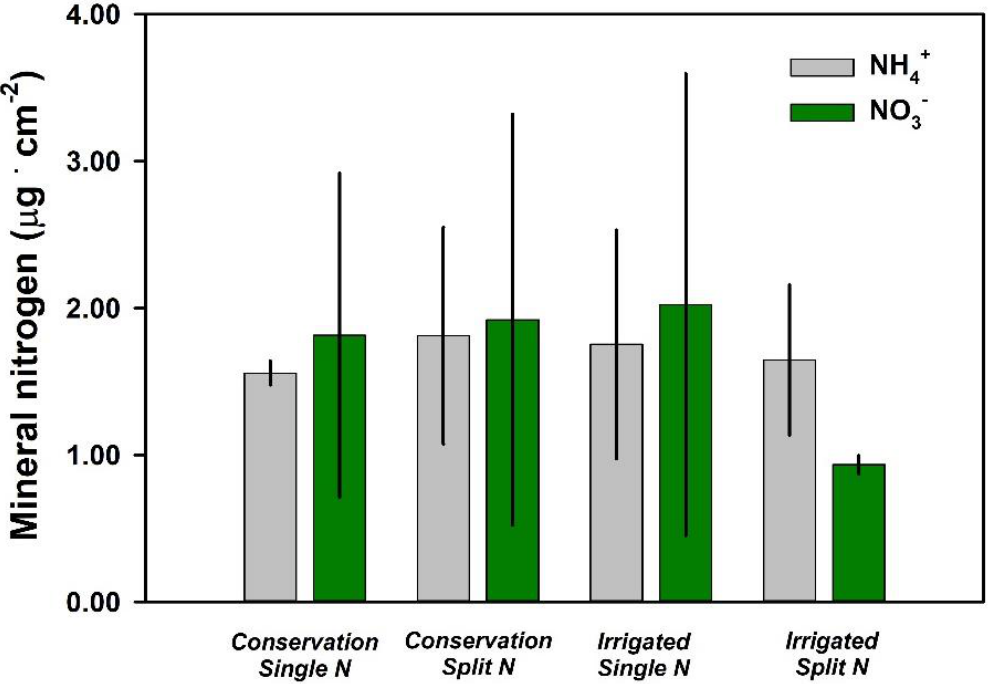
Figure 6. Soil mineral nitrogen (NH 4 + -N, NO 3 − -N) in sorghum fields under 30% less irrigation and full irrigation, and with N fertilizer applied once at the start of the growing season or spilt into two applications. Grey bars denote ammonium, green bars denote nitrate, error bars are ± 1 SD.